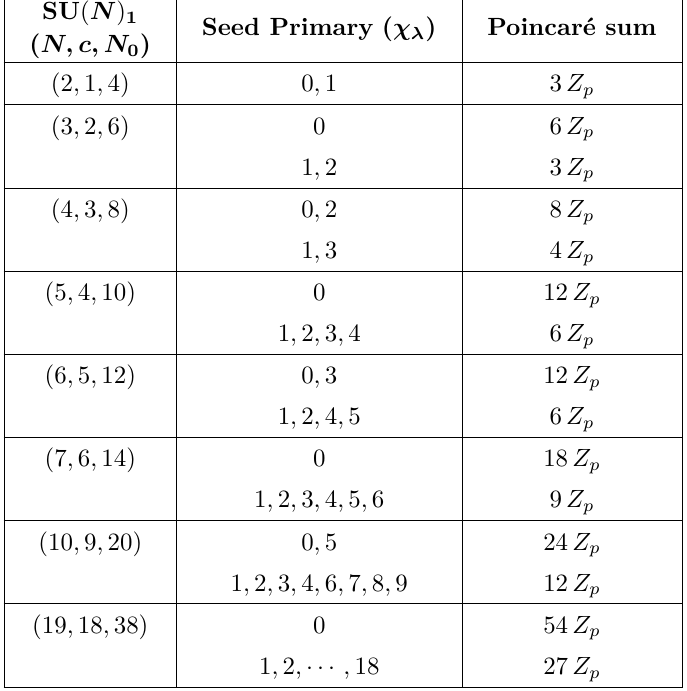
Table 4. Poincaré sums for SU( N ) 1 WZW models with a unique modular